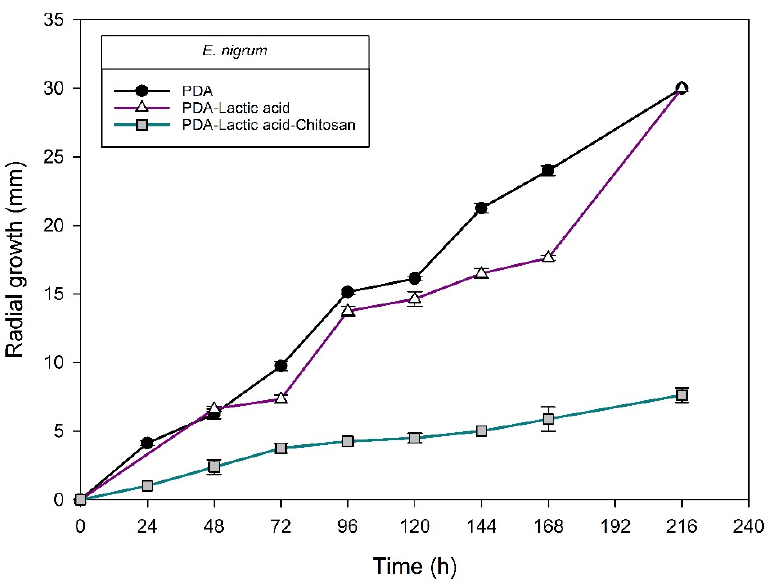
Figure 13. Epicoccum nigrum isolated from anthracnose of mango. Kinetics of radial growth (mm) in medium PDA, PDA-lactic acid (0.05 M), and PDA-lactic acid (0.05 M) with 1 g L − 1 chitosan at 25 °C. Fungal isolates of plant tissue with anthracnose in mango from Mexico belong to the Colletotrichum complex. The use of seven genetic markers in the genomic alignment identi- fied the species C. fructicola, C. musae , and C. chrysophilum . The fungi of the Colletotrichum complex are susceptible to chitosan except for two isolates of the species C. fructicola that showed less susceptibility to chitosan. Likewise, the genera Alternaria , Fusarium , Pestalo- tiopsis , Curvularia , Diaporthe , and Epicoccum , which cause other diseases in mango, showed susceptibility to chitosan in all cases. Therefore, chitosan is an alternative to be evaluated in the control of anthracnose and other fungal infections in mango. However, due to the demonstrated lower susceptibility to chitosan presented by a C. fructicola specimen,